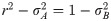
Selection condition when aG = r + σA, aR = r − σA, bG = 1 + σB, and bR = 1 − σB.The graph is bipartite, regular, and properly two-colored with NG = NR = 50. The difference between fixation probabilities of the two types, ρA − ρB, is shown for several values of σA and σB when r = 1.5. Warmer colors represent greater differences between the fixation probabilities, ρA − ρB. A is neutral relative to B if and only if r2-σA2=1-σB2.